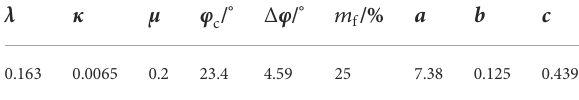
TABLE 5 Model parameters. Data from Machado et al.31